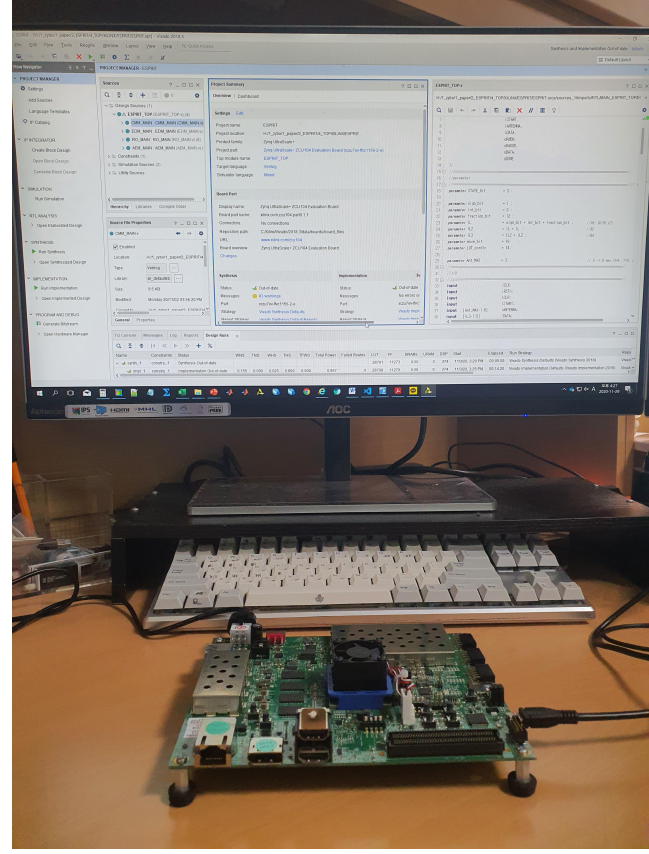
Figure 12. Verification environment using system-on-chip (SoC)